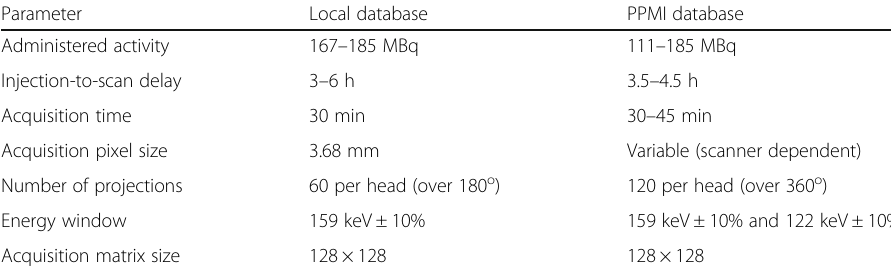
Table 1 Summary of patient preparation and image acquisition